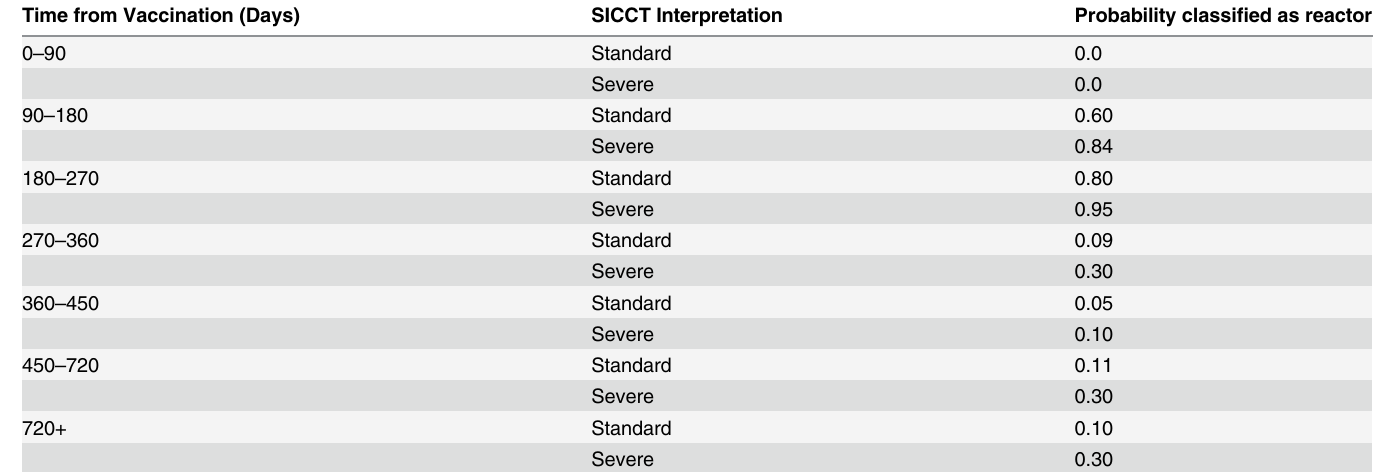
Table 11. Time-dependent sensitisation of vaccinates to SICCT